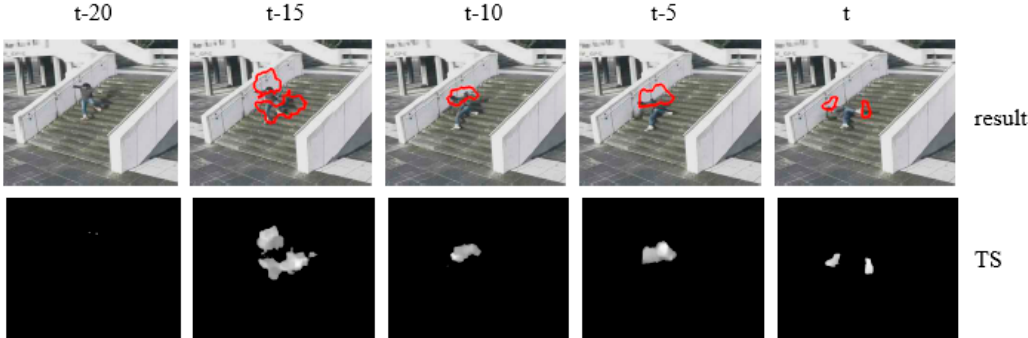
Figure 15. Examples of detection results for abnormality from the No. 8 data.